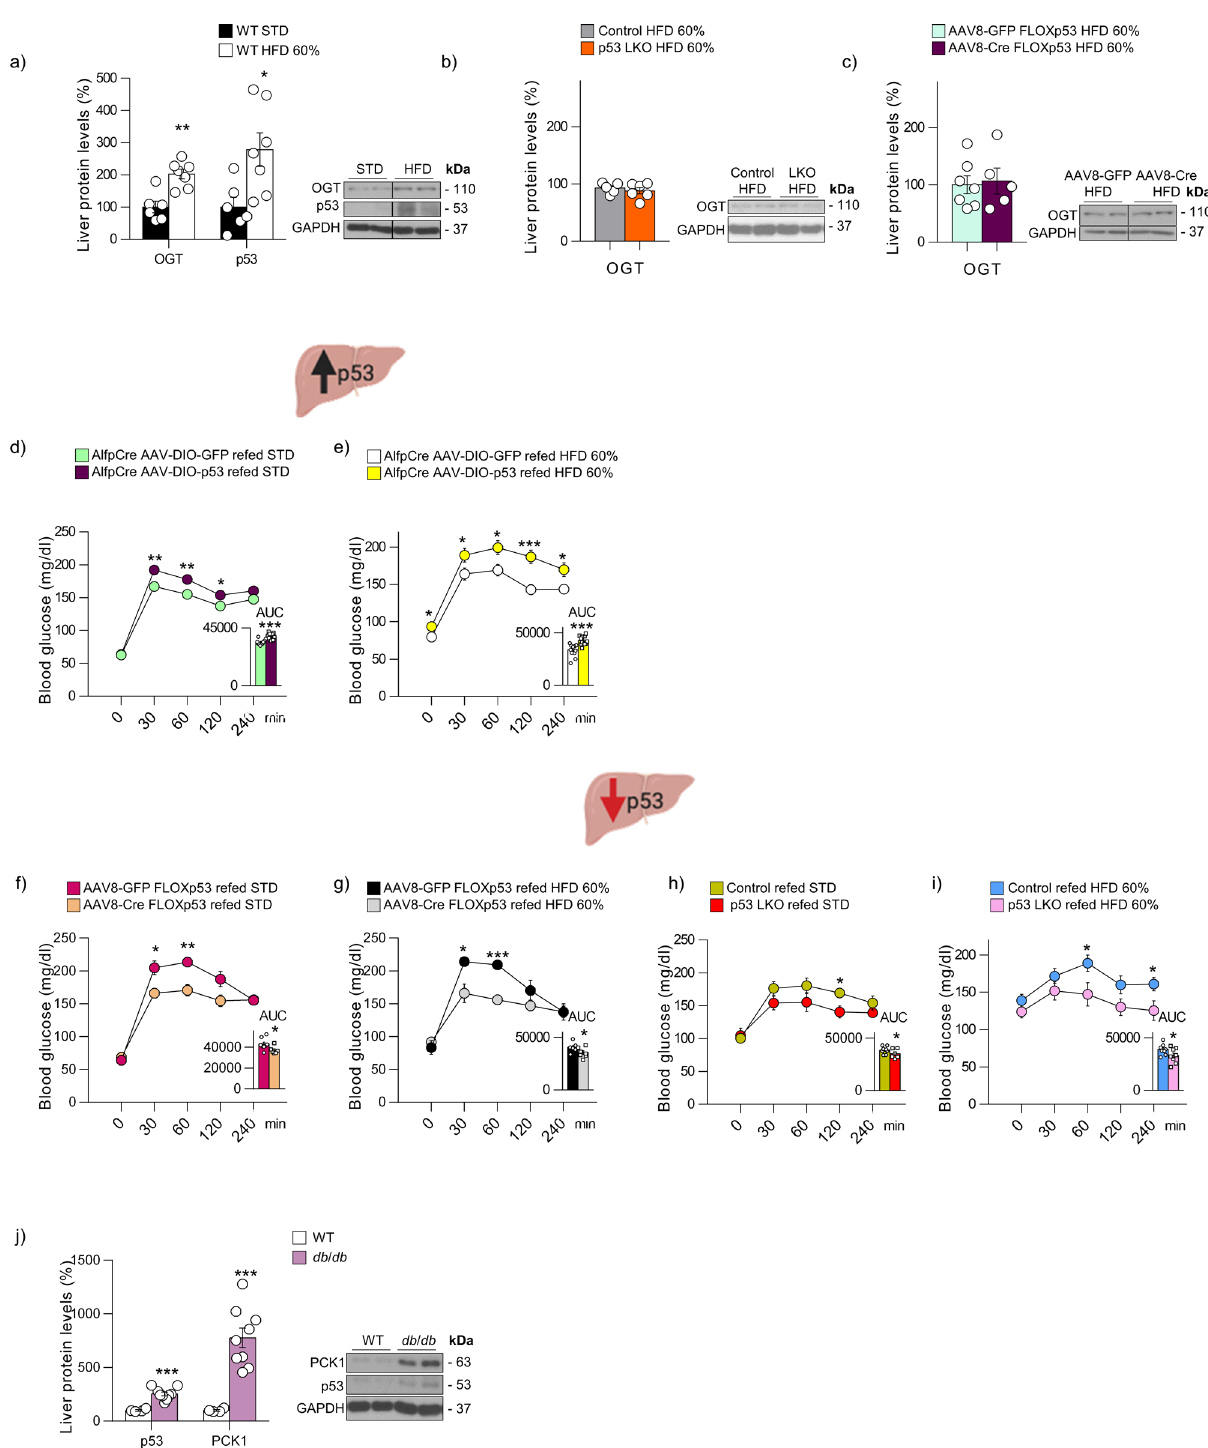
Fig. 8 Hepatic p53 affects postprandial hyperglycemia and is elevated in models of insulin resistance. a Hepatic OGT and p53 protein levels in WT mice fed with standard diet or high-fat diet (HFD) 60% for 4 days ( n = 7). Hepatic OGT protein levels in ( b ) control mice and p53 LKO mice fed with HFD 60% for 4 days ( n = 6) and c FLOXp53 mice injected with AAV8 expressing either GFP ( n = 7) or Cre ( n = 5) and fed with HFD 60% for 4 days. Blood glucose levels in Alfp-Cre± mice injected with AAV-DIO expressing either GFP or p53 refed with d chow diet ( n = 11 and 12) and e HFD after overnight fasting ( n = 11 and 12). Blood glucose levels in FLOXp53 mice injected with AAV8 expressing either GFP or Cre refed with f chow ( n = 6 and 8) diet and g HFD after overnight fasting ( n = 5 and 6). Blood glucose levels in control and p53 LKO ( n = 6) mice refed with h chow ( n = 5 and 7) diet and i HFD ( n = 7) after overnight fasting. j Hepatic p53 and PCK1 protein levels in WT ( n = 4) and db / db mice ( n = 9). The area under the curve (AUC) is provided. Expression of GAPDH served as a loading control and control values were normalized to 100%. Dividing lines indicate splicings within the same gel. Data were presented as mean ± standard error mean (SEM). * denotes P < 0.05, ** denotes P < 0.01, and *** denotes P < 0.001, determined by two-tailed Student ’ s t -test. “ n ” denotes independent animals. Source data are provided as a Source Data fi